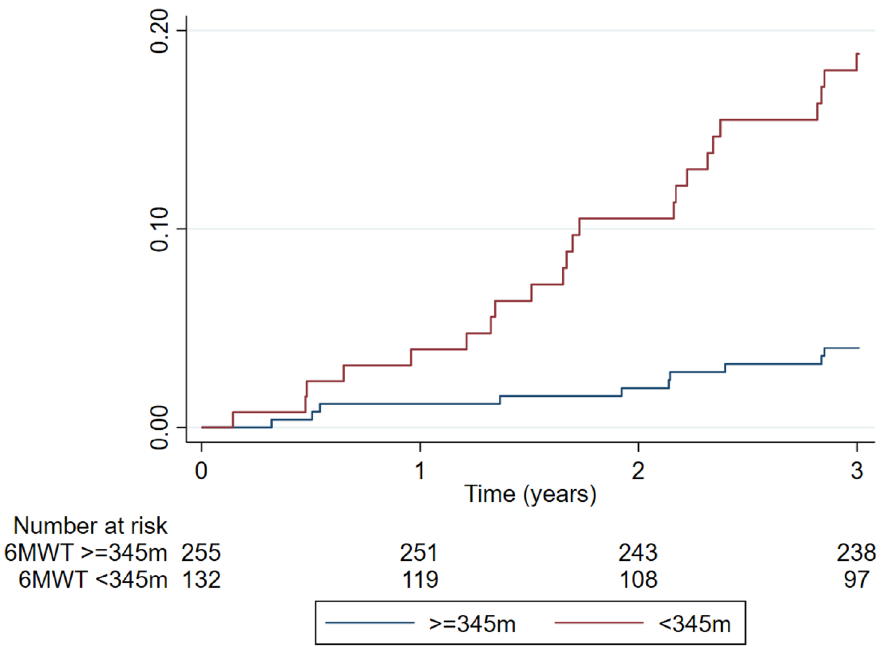
Figure 1. Kaplan–Meier failure curve comparing patients who walked less than 345 m with those who walked 345 m or more in the 6MWT. 6MWT, 6-minute walking